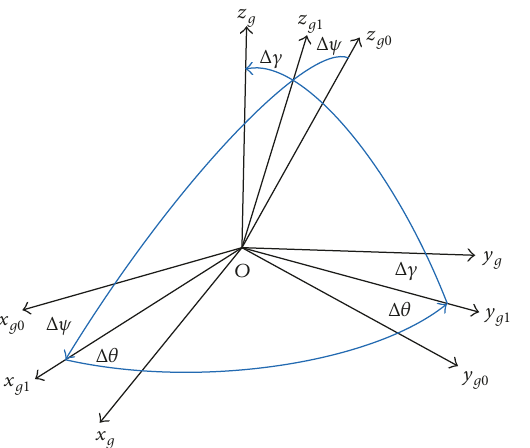
Figure 3: Orientation error of GyroWheel axes. Ox intended orientation of the GyroWheel axes. Ox orientation of the GyroWheel